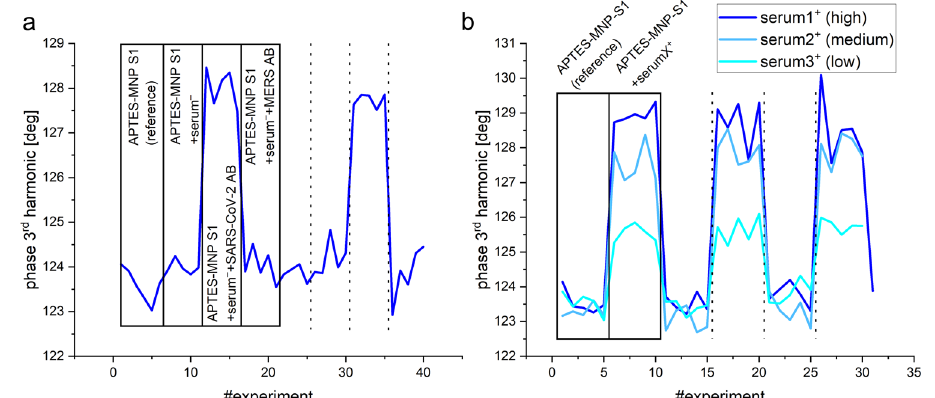
Fig. 7 | First blood serum experiments. a Calibration experiment investigating possible cross-binding effects between blood serum and APTES-MNP-S1 particles. The measurement sequencewas5×reference,5×serum0 – ,5×serum0 – +SARS-CoV- 2 ABs, 5× serum0 – +MERS ABs with two repetitions for calibration experiment. b Resultsforthreedifferentbloodseraobtainedfromhealthystaffmembersofthe Institute of Virology and Immunobiology with informed consent. Serum anti-spike IgG levels were quanti fi ed using the LIAISON® SARS-CoV-2 TrimericS IgG assay